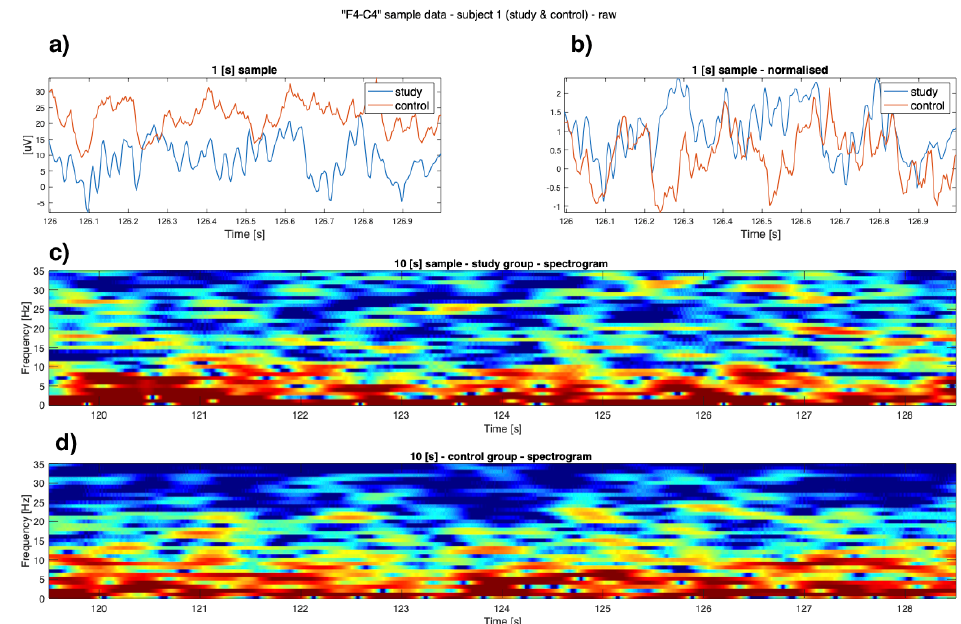
Figure 1. Example raw data from channel ’F4-C4’ : ( a ) time-series of both study group and control group (1 [s]); ( b ) normalised time series of study group and control group (1 [s]); ( c ) 10 [s] sample of FASD (top spectrogram); ( d ) 10 [s] of healthy control (bottom spectrogram)—sample 1.